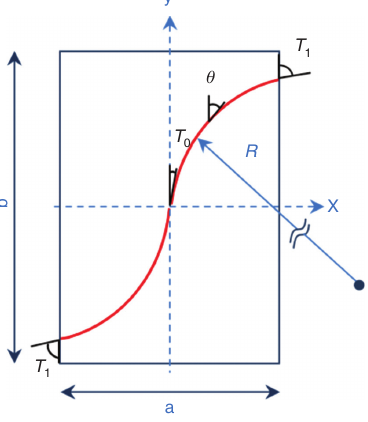
Figure 1 Constant curvature fiber path